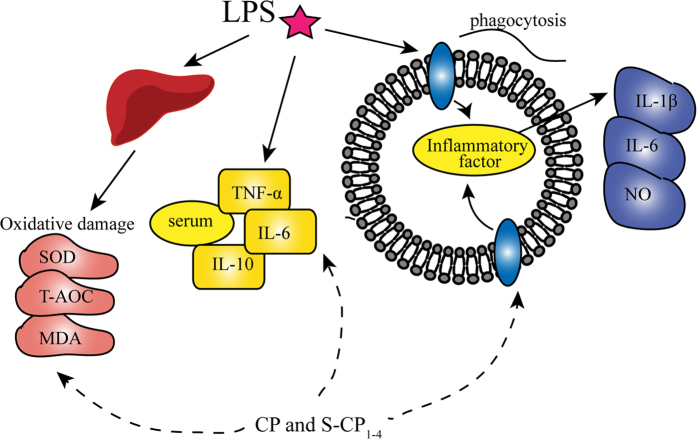
The possible anti-inflammatory mechanism of CP and S-CP1–4.